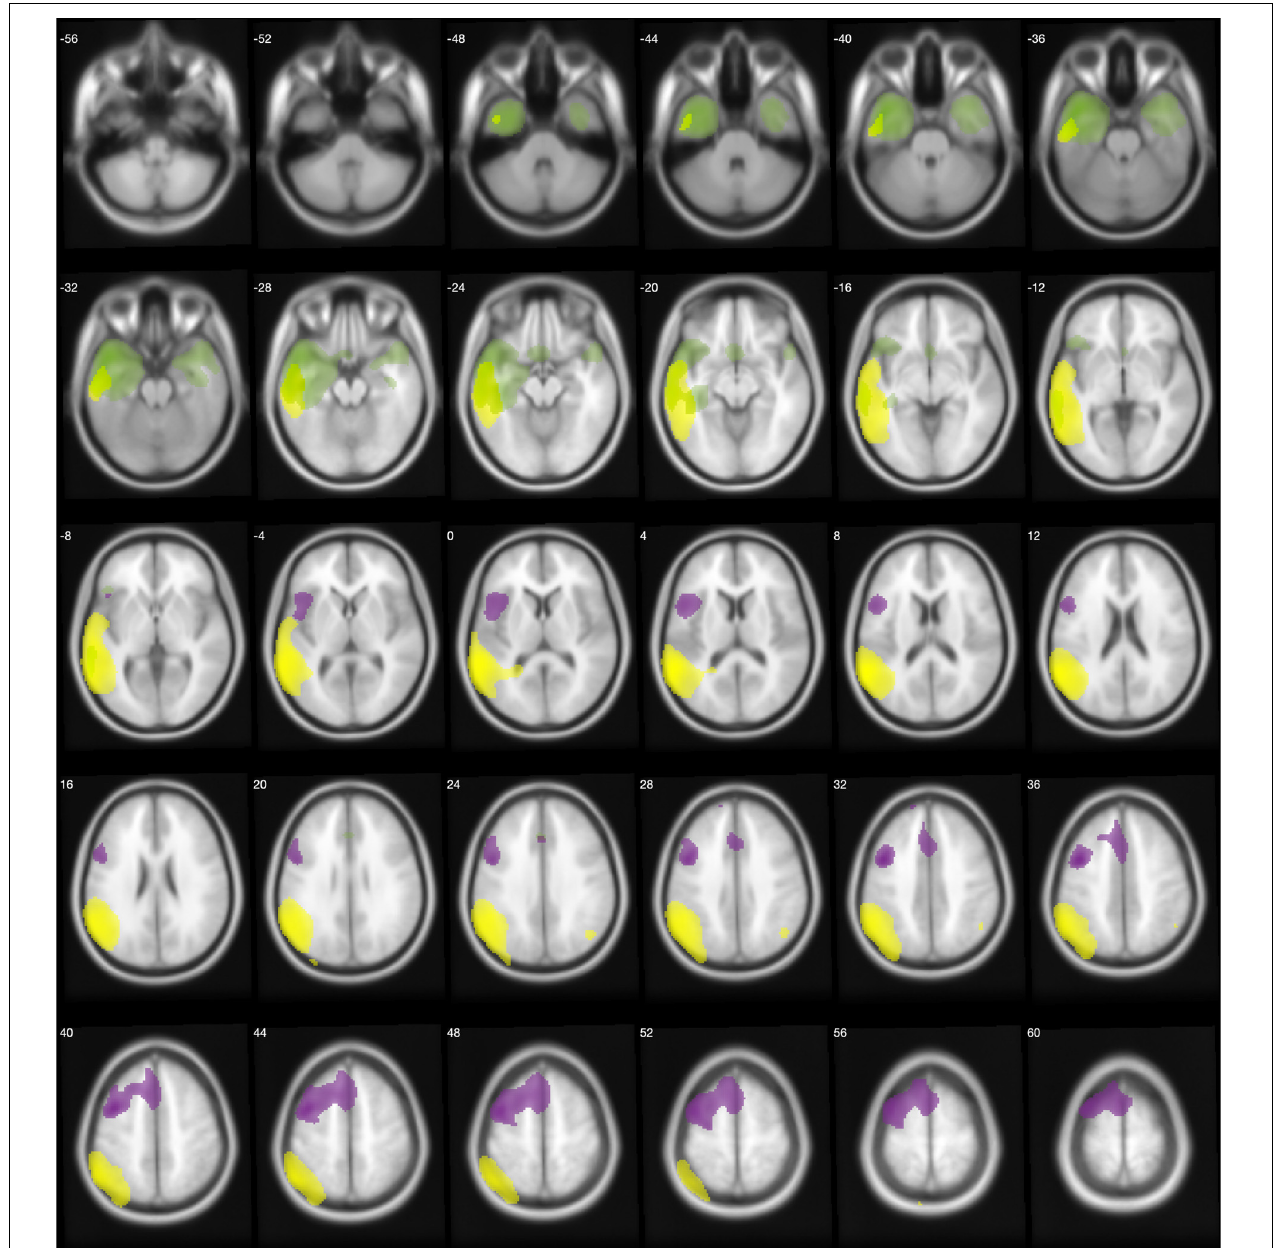
FIGURE 2 | Regions with lower metabolism in the PPA variants displayed on an MRI template. nfPPA (violet), svPPA (green), and lvPPA (yellow) were compared with healthy controls using a 2-sample t -test with a family-wise error corrected p < 0.05. Images are shown using neurological